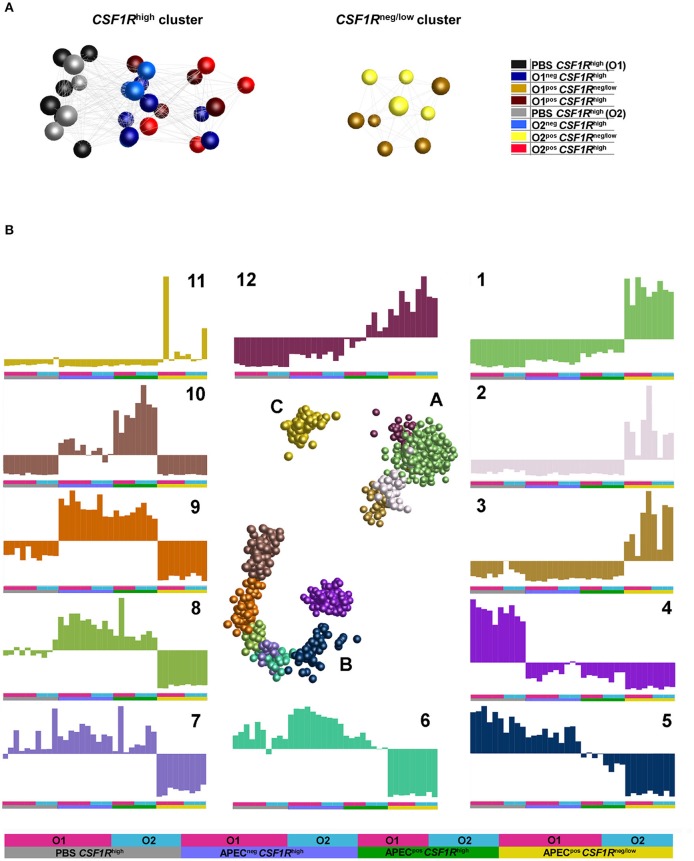
Network graphs of gene expression (normalized counts per million). (A) Sample-sample network graph. The graph is colored based on experimental groups and shows primary separation of samples based on CSF1R-transgene expression. (B) Gene-gene network graphs. The graph is colored by clusters determined by MCL clustering, with three separated clusters of genes (A–C) comprised of 12 separate clusters. The expression of each cluster is shown in the graphs labeled 1–12, with the experimental groups denoted by a key at the base of the figure and used under each graph.